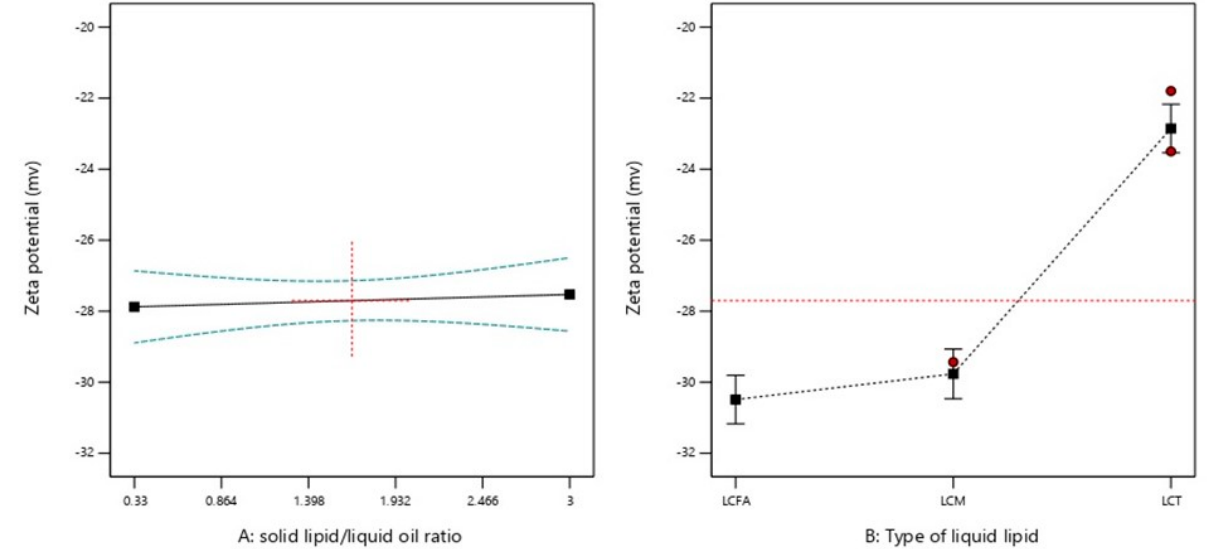
Figure 4. Graphical representation of the effects of ( A ) solid lipid: liquid oil ratio and ( B ) type of liquid oil on zeta-potential value. Red dotted horizontal line and plus sign represent the average value over factor B at the focused point of factor A = 1.665, respectively. Green dotted lines represent 95% CI bands. Red circles and black squares represent design points and predicted values, respec- tively.